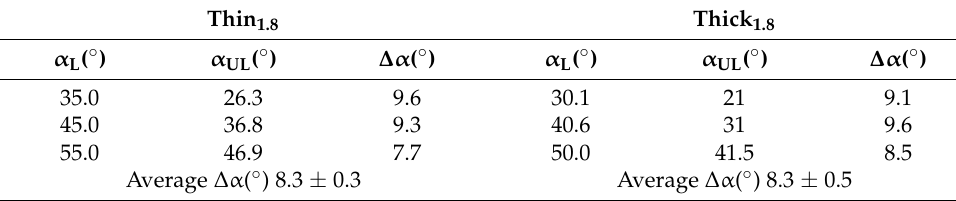
Table 4. The results of interrupted bending tests for the 1.8 mm Al–Si-coated